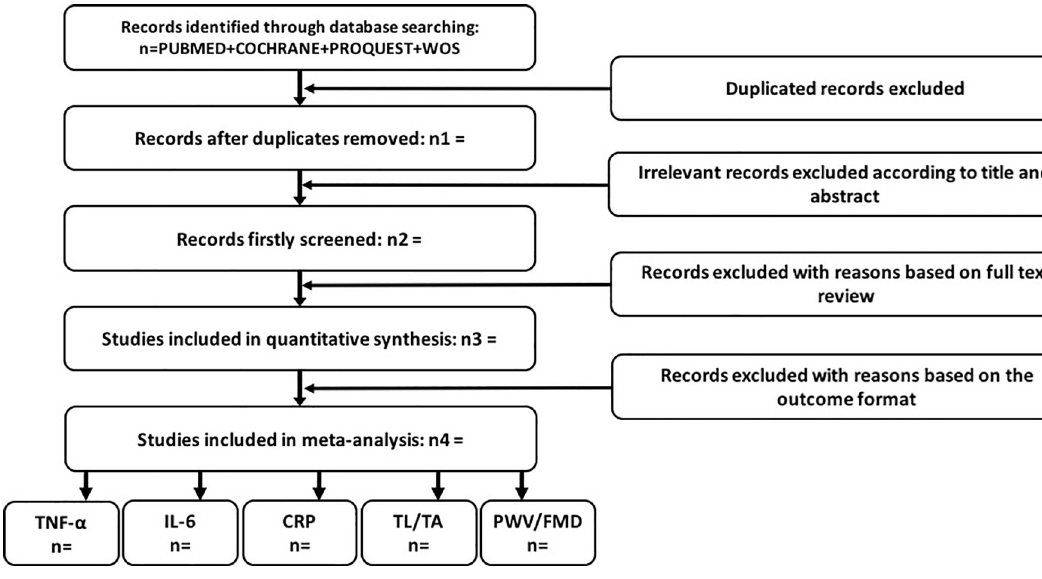
Fig 2. A flowchart of study